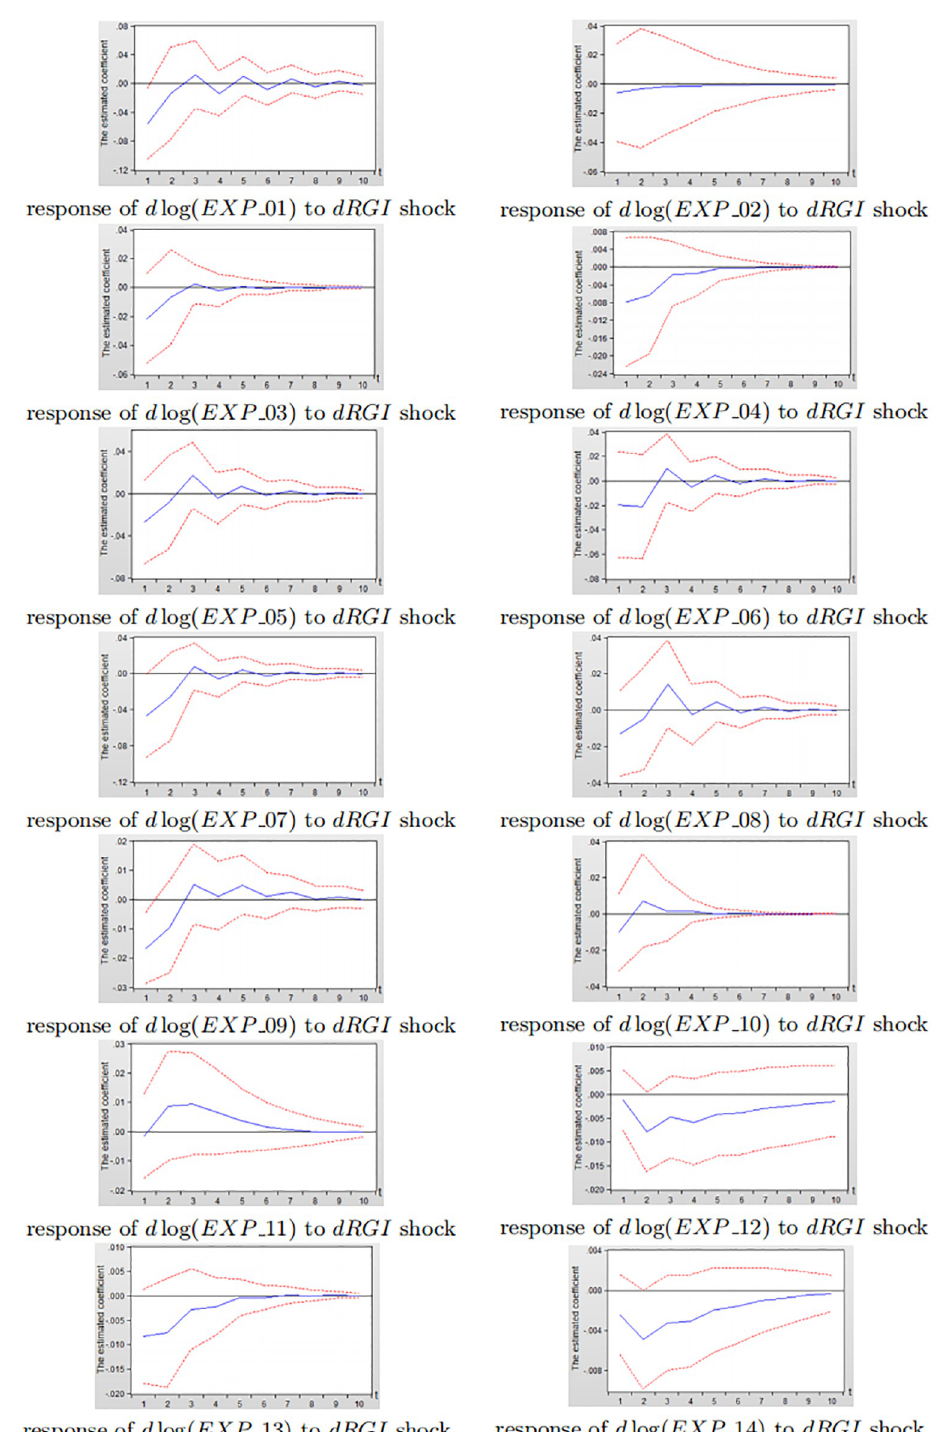
Fig 15. Impulse response diagram of reverse globalization to the United States subdivided service exports.